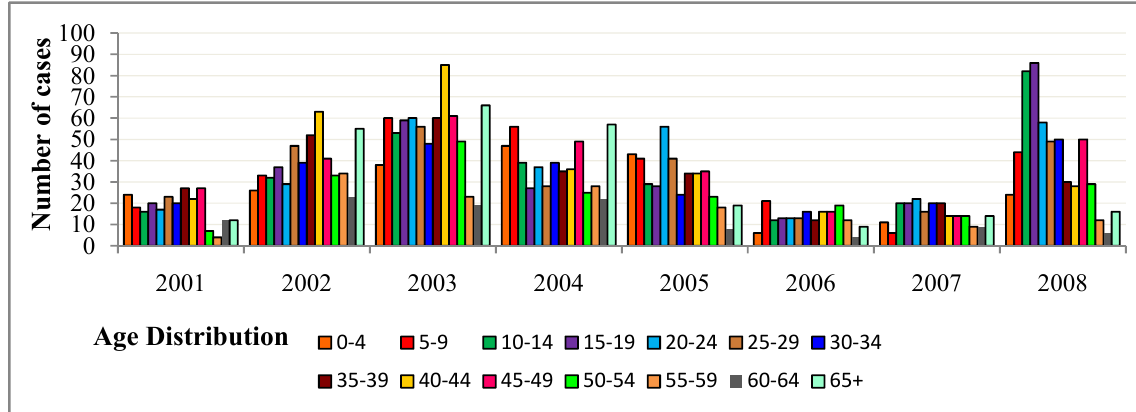
Figure 3. Number of influenza cases classified by age groups during the years 2001–2008.